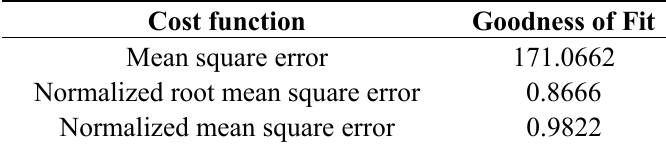
Table 2. Goodness of fit between test and reference data.